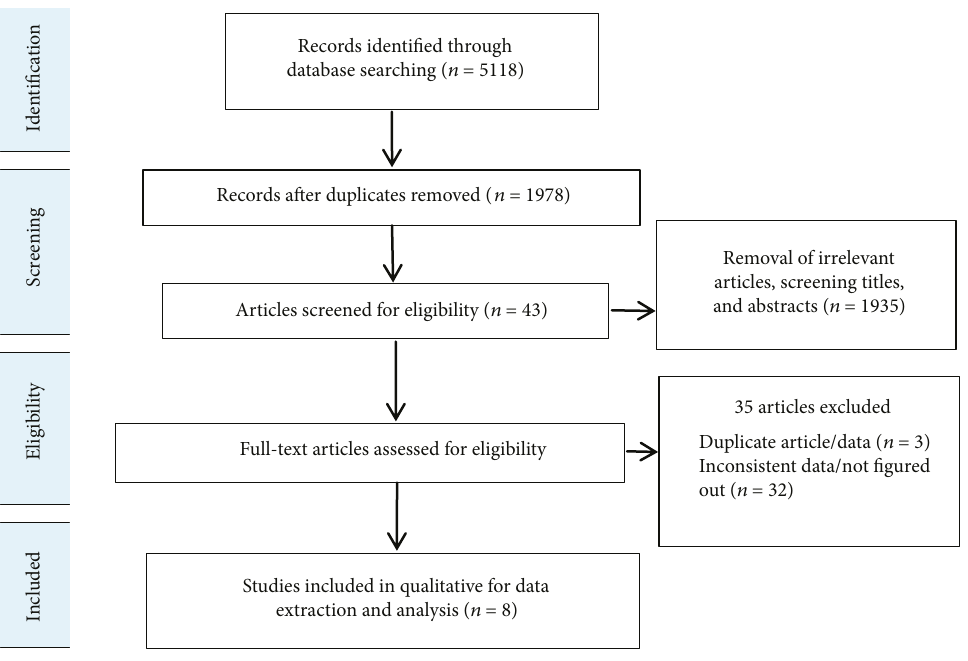
Figure 1: Procedure of the selection